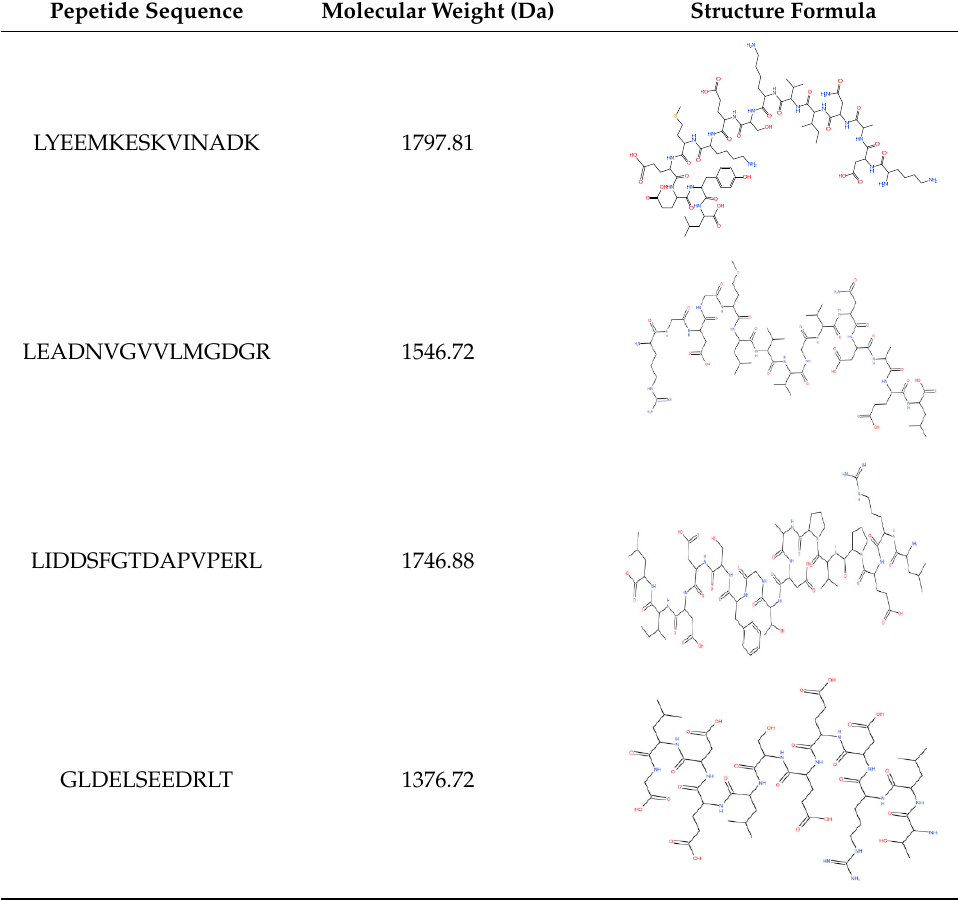
Table 1. Antioxidant peptides from G. livida identified by LC–MS/MS .